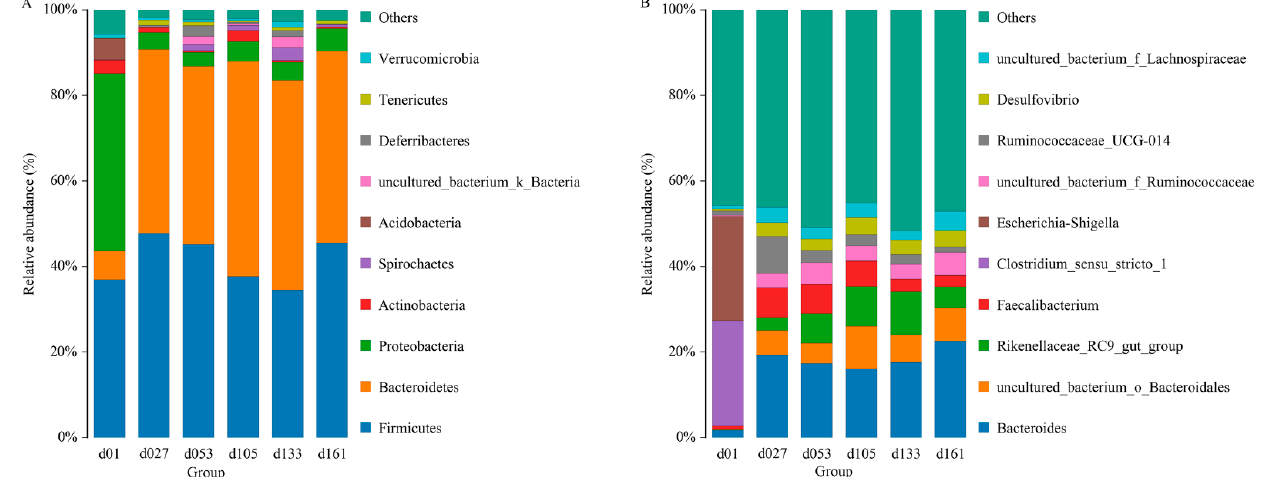
Figure 1. Top ten of the microbial composition at the phylum level ( A ) and genus level ( B ). Each bar represents the average relative abundance of each taxon within a time point. d01, n = 12; d027, n = 11; d053, n = 12; d0105, n = 12; d133, n = 12; d161, n = 12.